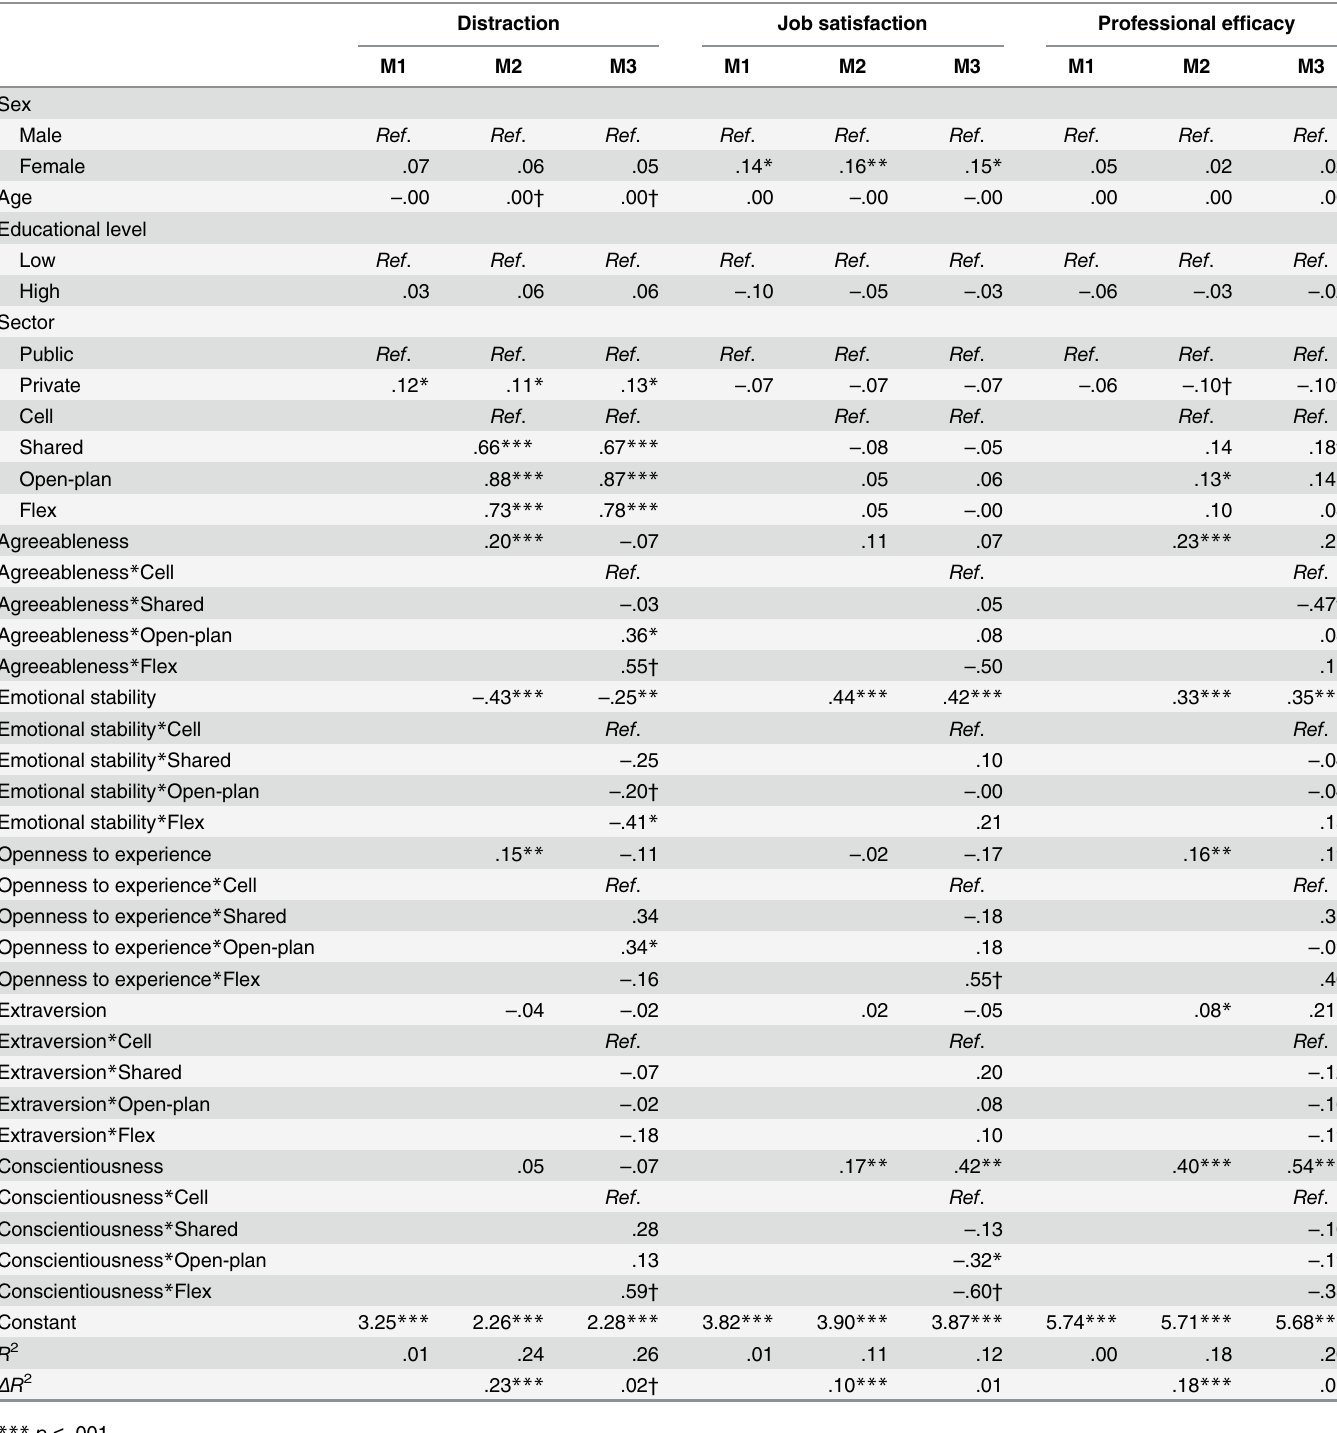
Table 2. Distraction, job satisfaction and professional efficacy in relation to the main effects and interactions of office type and Big Five personal- ity traits, N = 1205, unstandardized beta